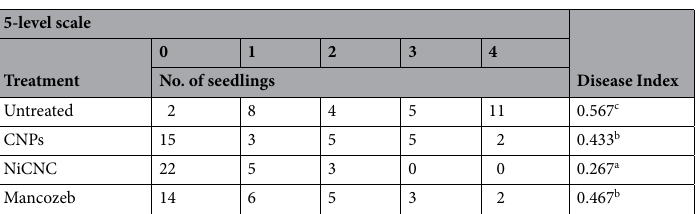
Table 1. Representation for observation of seedling symptoms on the basis of 5-level scale by Santori and Infantino (2009), their disease index values. The values followed by the letter a, b and c showed significant difference at p ≤